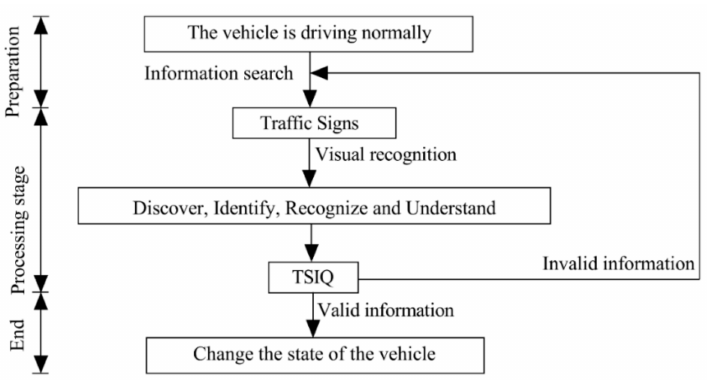
Figure 1. The driver’s information processing process.